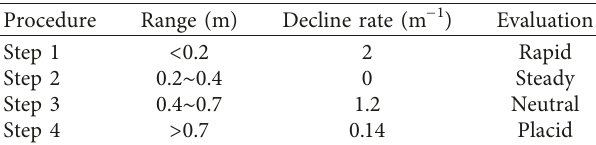
Figure 9: Dissipation characteristics of ζ along L Table 5: Dissipation characteristics of ζ .